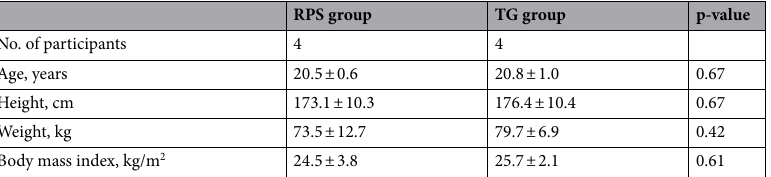
Table 1. Physical characteristics of participants in the RPS and TG groups. Values are presented as the mean ± standard deviation. RPS: rock-paper-scissors; TG: towel gathering. The independent-samples t-test was used to evaluate differences between the RPS and TG groups. Statistical significance was set at P <